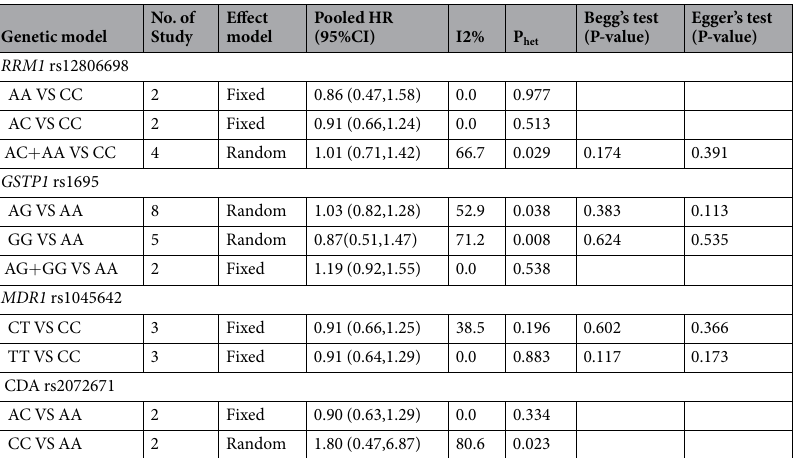
Table 3. The association between candidate gene polymorphisms and OS. a Begg’s test P < 0.05; b Egger’s test P <